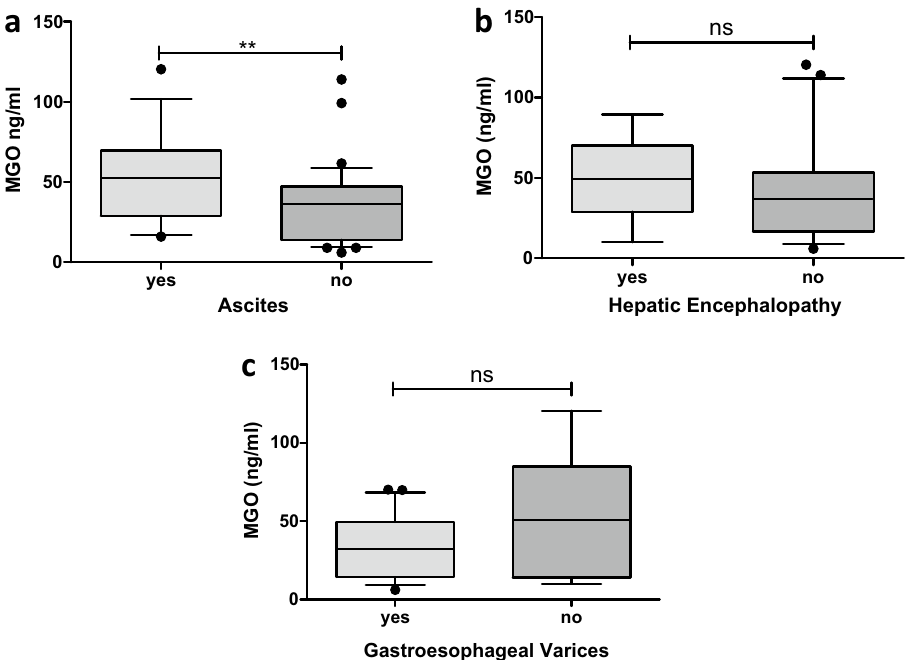
Figure 2. Whisker boxplots showing median (IQR 10th; 90th) MGO serum levels with respect to the presence of liver-related complications. ‘Yes’ or ‘no’ indicates whether the characteristic was present at study inclusion. ( a ) Patients with ascites at study entry showed higher MGO levels. The MGO levels were not elevated in patients presenting with hepatic encephalopathy ( b ) or gastroesophageal varices ( c ). Differences between two groups were analyzed using the Mann–Whitney U test. The dots refer to values beyond the range of the 10th and 90th percentiles. *p < 0.05; **p < 0.01; ***p < 0.001; ns not significant.